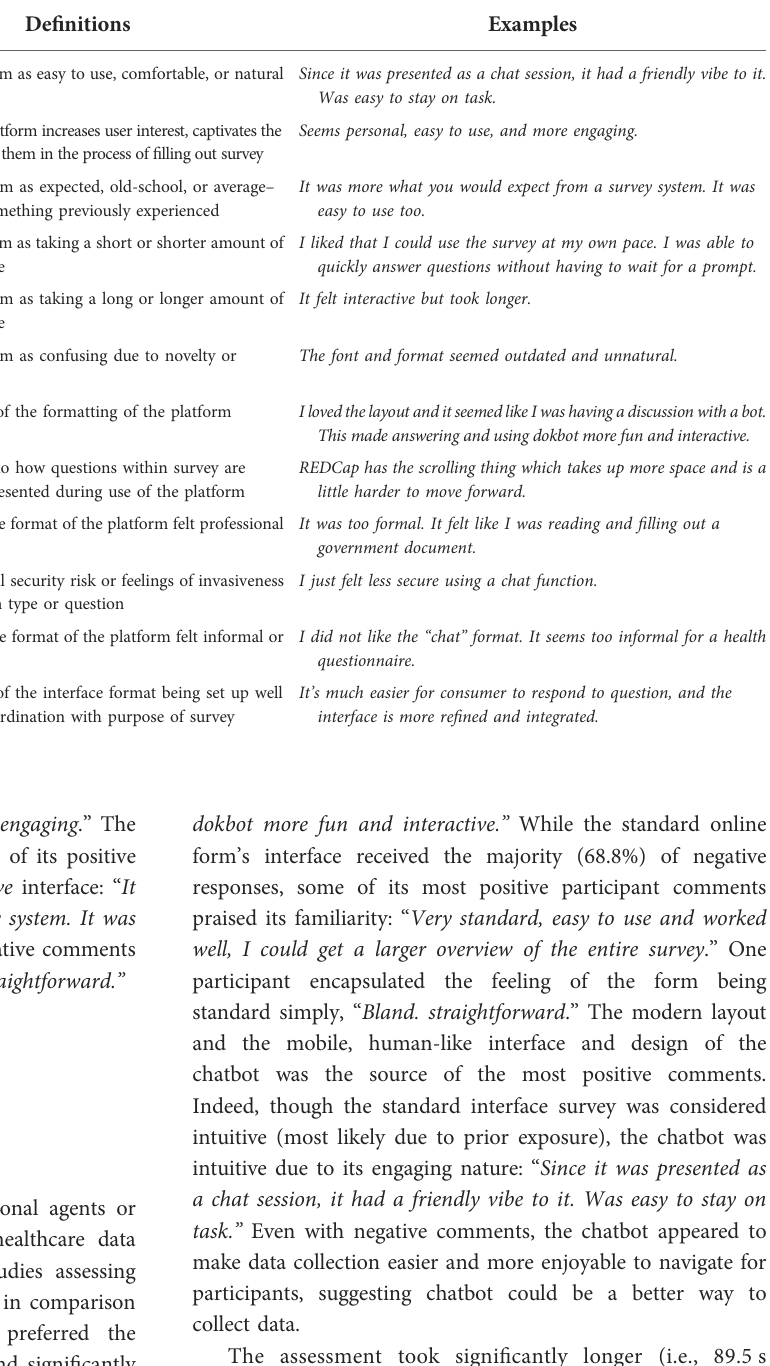
TABLE 5 Common emerging themes and